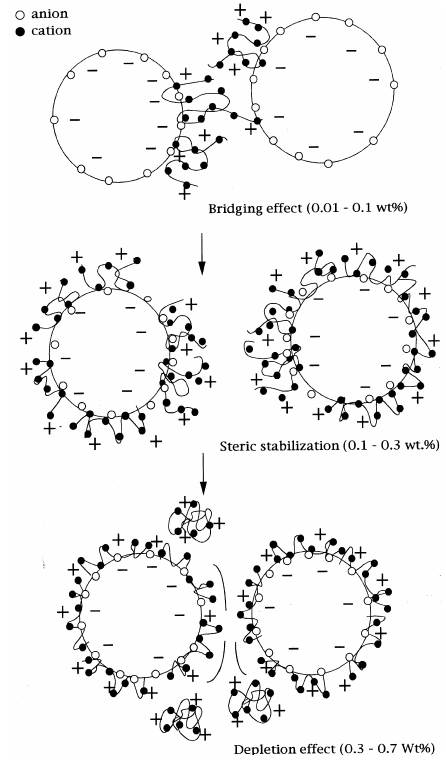
Figure 2. A schematic representation to explain the effect of PLL on the flocculation behavior of latex dispersion. Reprinted from [106], Copyright (1999), with permission from